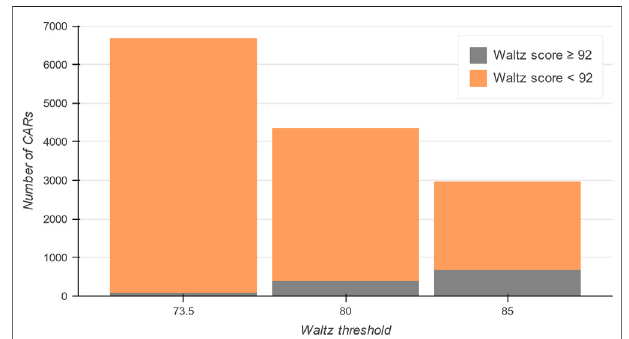
FIGURE 3 | Total number of entries in the CARs-DB database for all DisProt regions. In grey, conventional amyloidogenic peptides are shown with a Waltz score over 92. The proportion of CARs dramatically increases as the threshold is more permissive (in orange), obtaining a collection of more than 8,900 unique CARs of polar